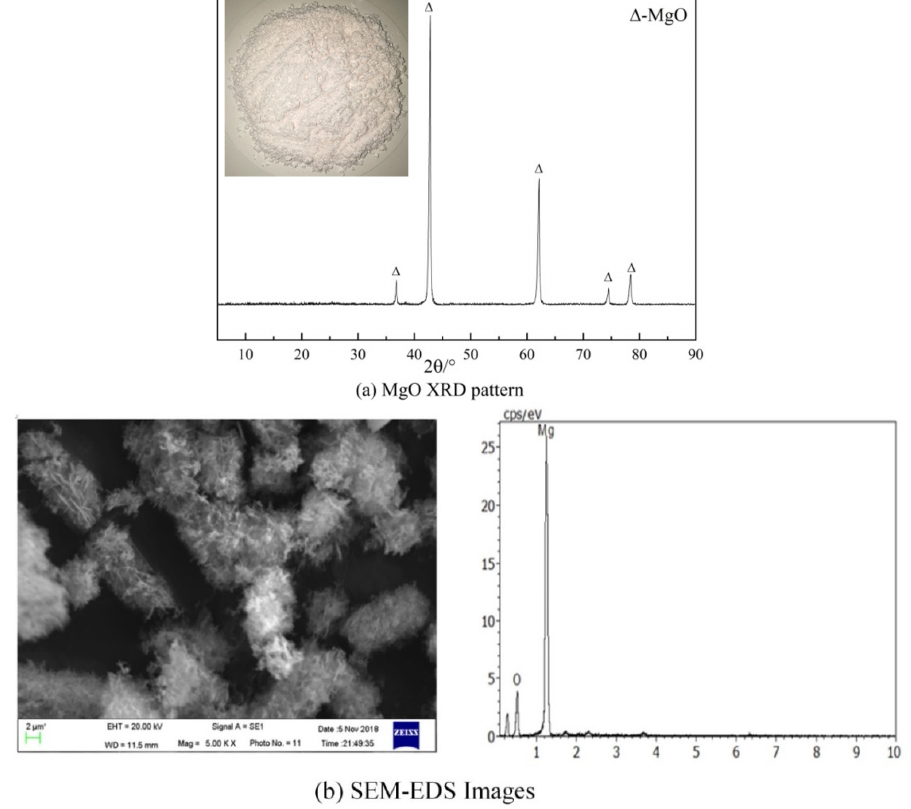
Figure 11. Analysis of calcined product ( a ) MgO XRD pattern; ( b ) SEM-EDS images. Table 9. Chinese industry standard for first-class magnesia index and product indexes.